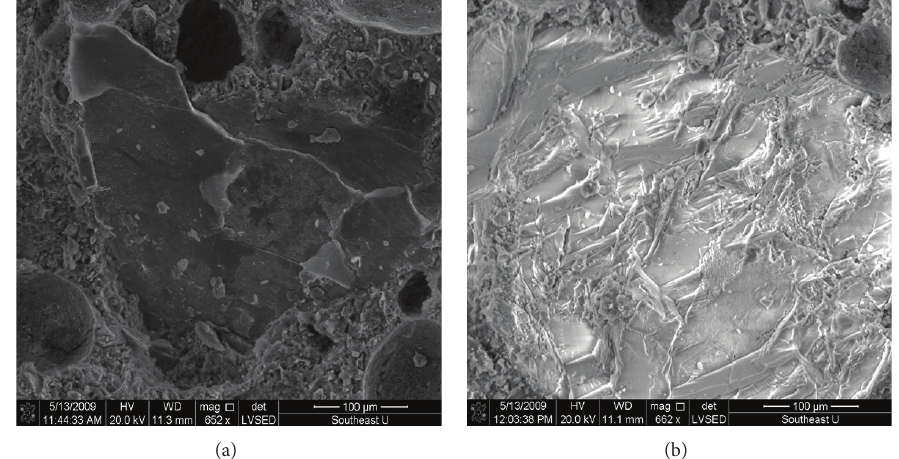
Figure 7: Microstructure morphologies of concrete with PVA at different hydration ages: (a) 3 days and (b) 28 days.